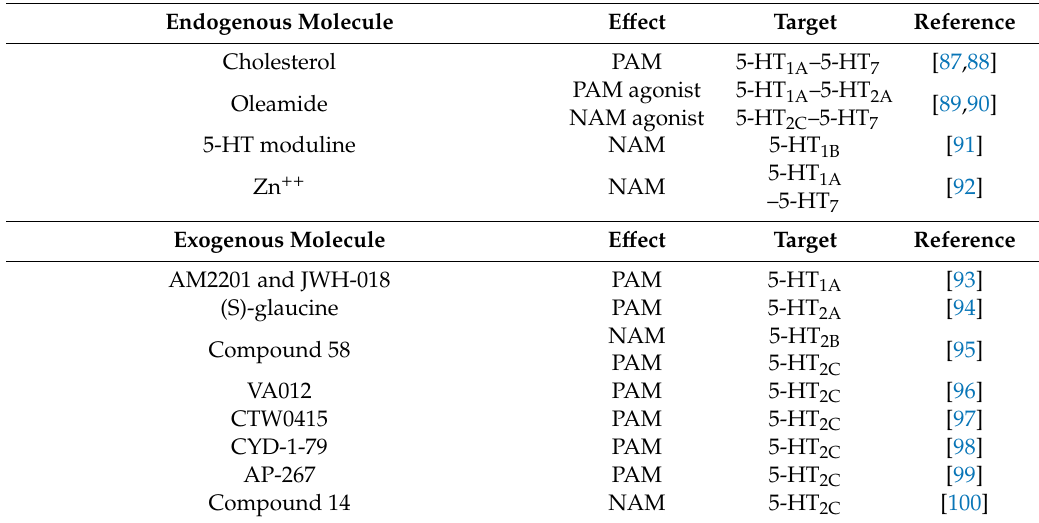
Table 2. Cont . Allosteric Modulators of Serotonin